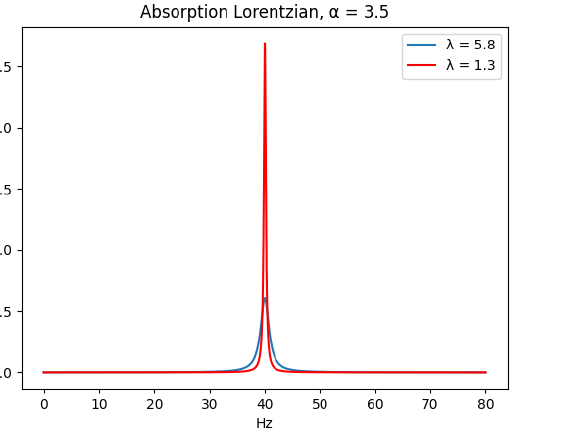
Figure 1. Two absorption Lorentzians that share the same frequency parameter. Both are multiplied by an intensity parameter α , which is set at